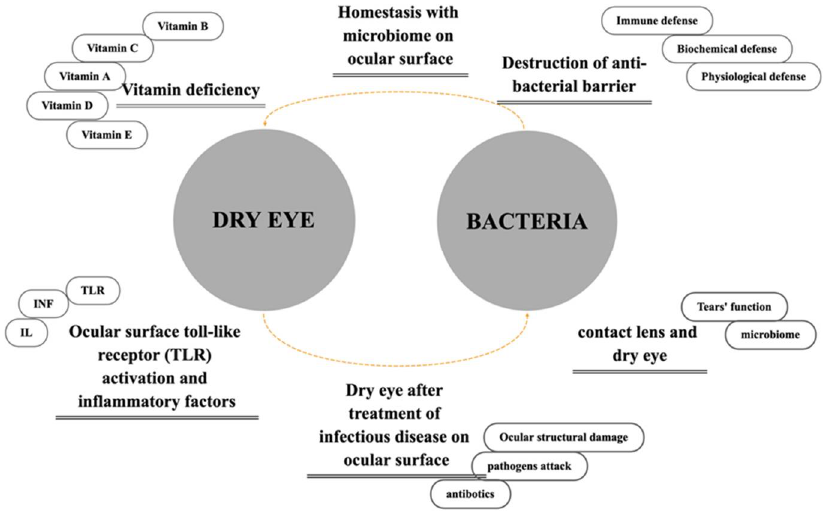
Figure 1. The mechanisms of dry eye disease.